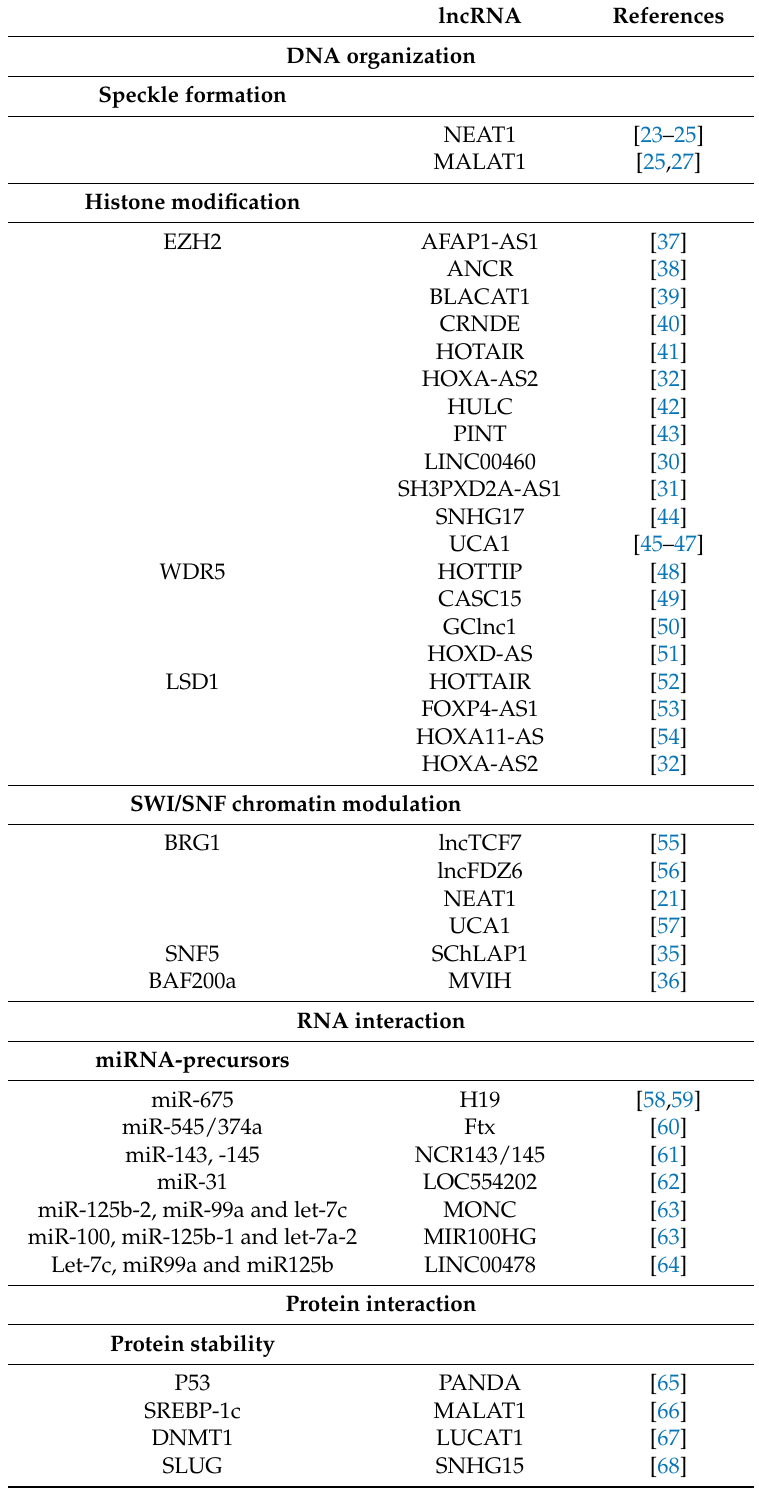
Table 1. The examples of long non-coding RNAs in cancer